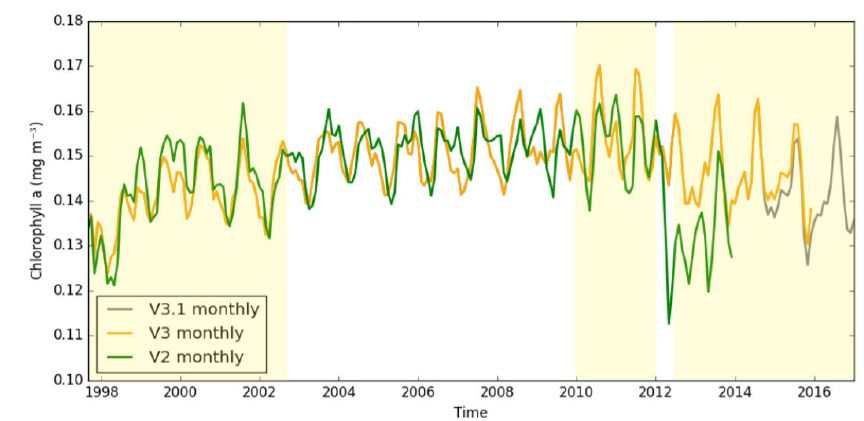
Figure 2. Comparison of the global median chlorophyll a concentration as function of time for v2.0, v3.0 and v3.1 using the monthly composite as input. Source: OC-CCI Product User Guide, release 3.1.0, 24 April 2017. The yellow shaded regions show the change of sensor combinations (see Table 1).